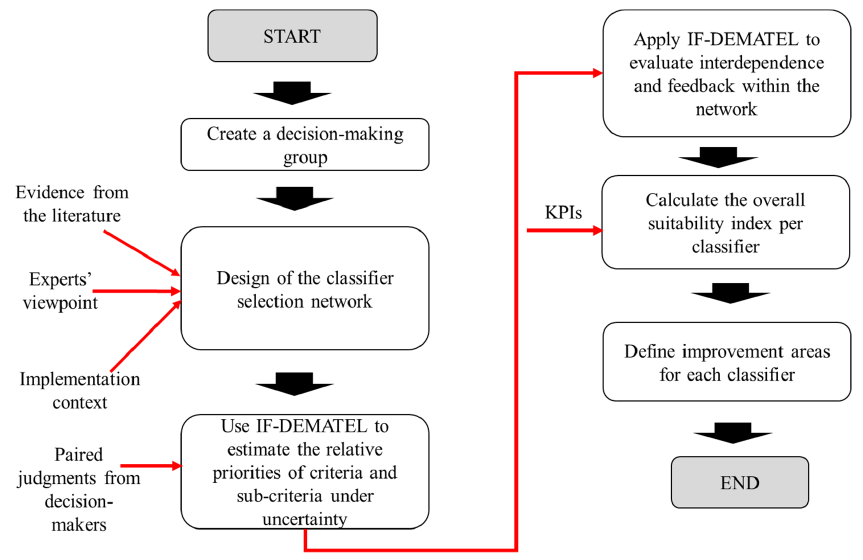
Figure 1. Proposed methodology for selecting the most suitable classifier considering the implemen- tation context of technology adoption.